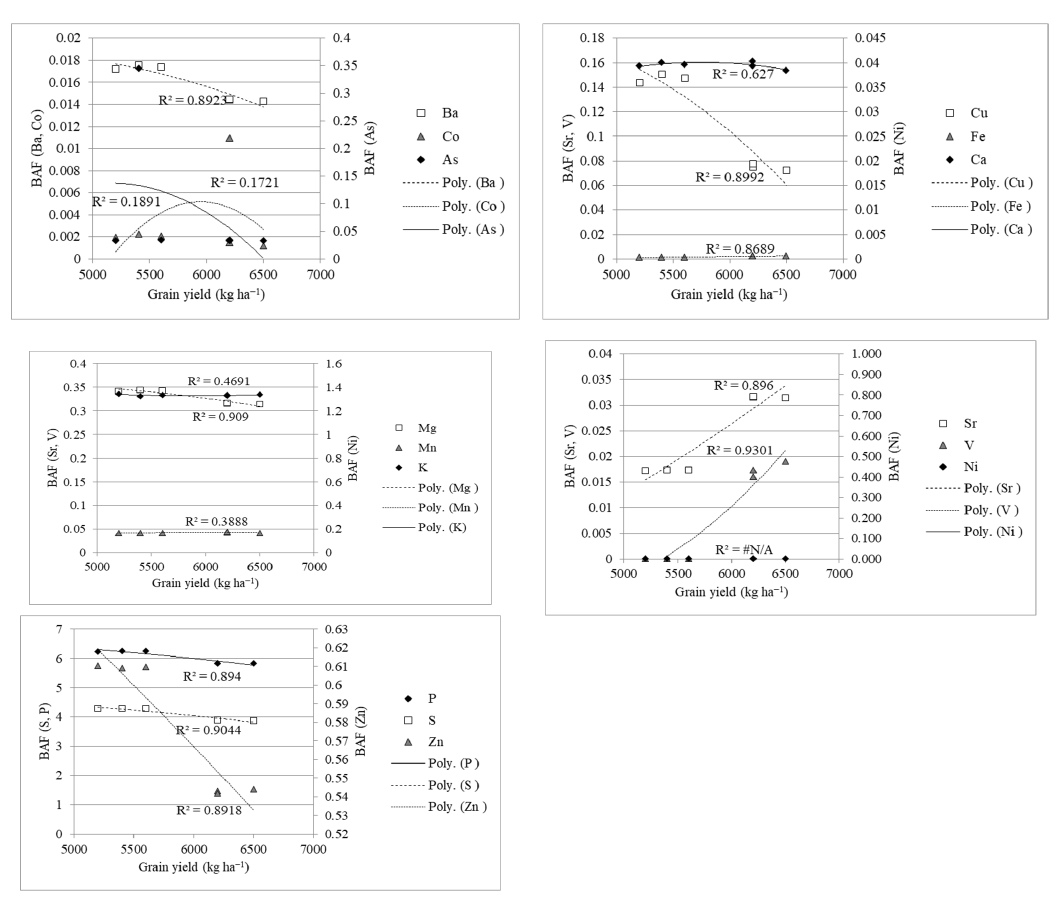
Figure A2. Interdependence (regression analysis) between grain yield and bioaccumulation factor (BAF) in wheat grain from conservation cropping system (CCS).